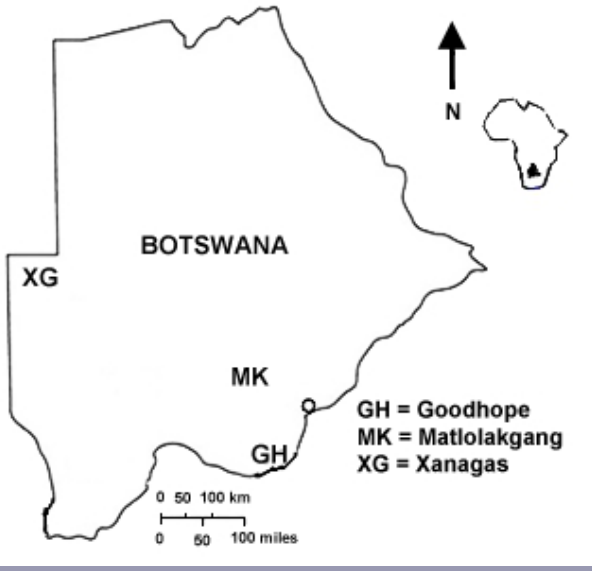
Fig. 1 . Locations of the three study sites in Botswana (Matlolakgang is located between Malwele and